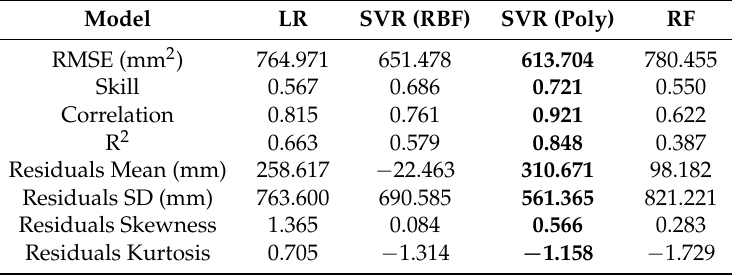
Table 3. Performance of each of the annual precipitation models on the testing data set (2011–2019). The best performing model for predicting annual precipitation is highlighted, determined by low RMSE, and both high correlation and